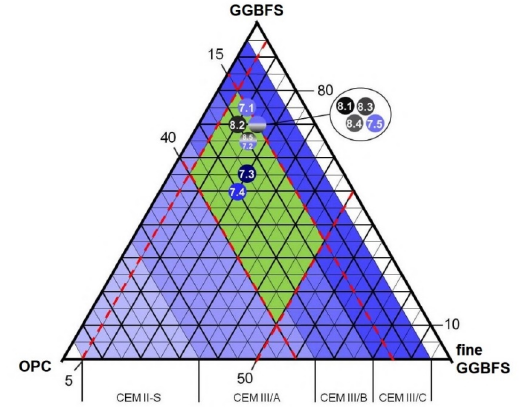
Figure 10. Optimized binder compositions for acid resistance